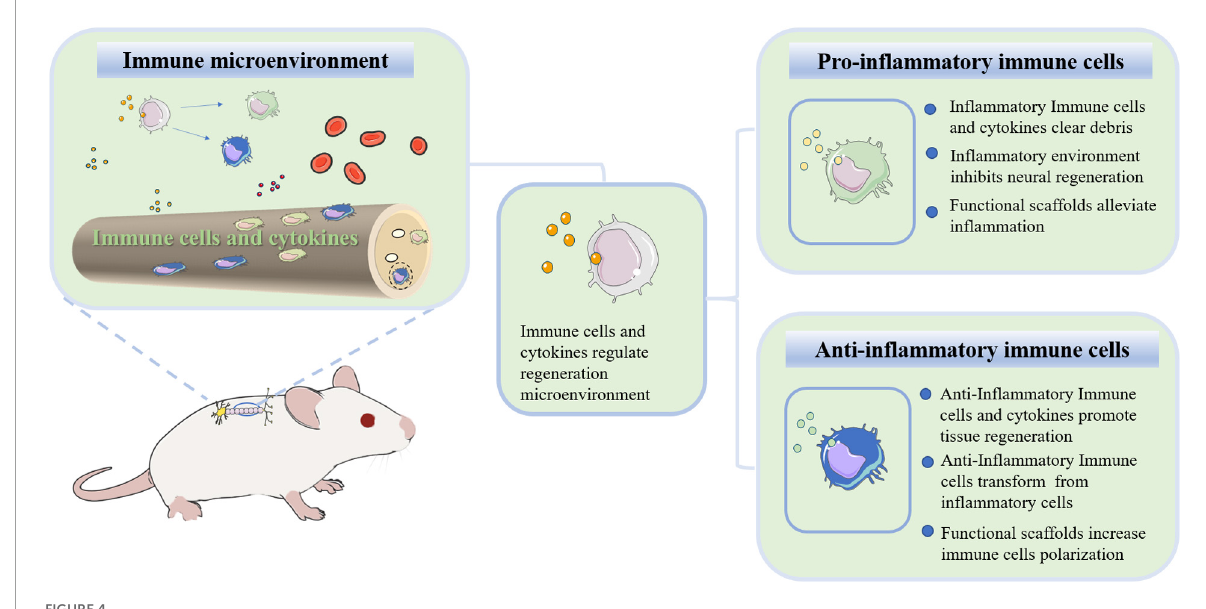
FIGURE4 Changes of immune cells in the microenvironment of spinal cord